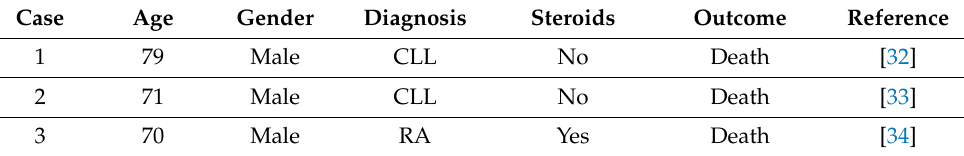
Table 2. Serious adverse events in immunized